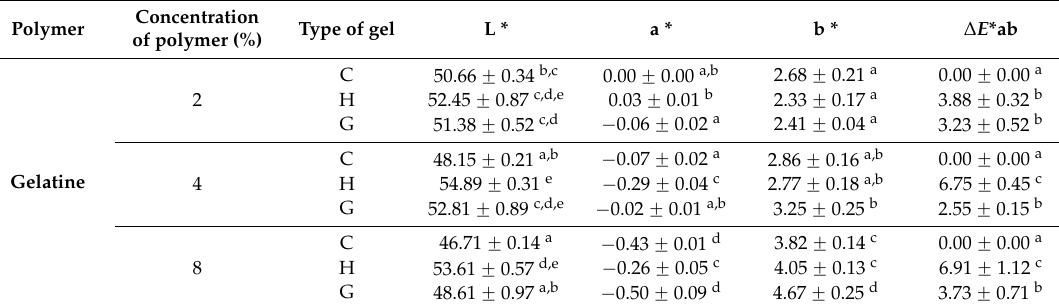
Table 3. The effects of DC on the color of hydrogels.